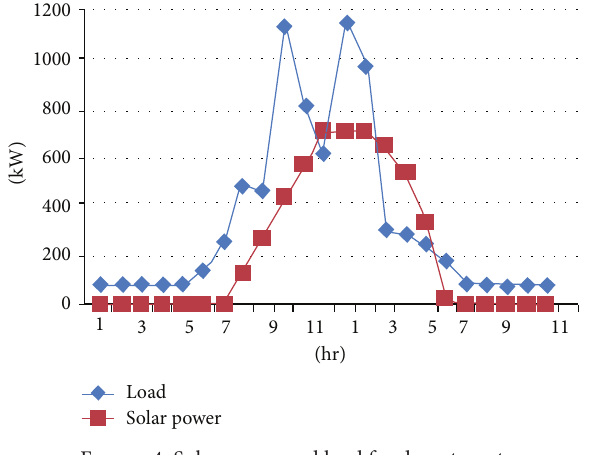
Figure 4: Solar power and load for department.